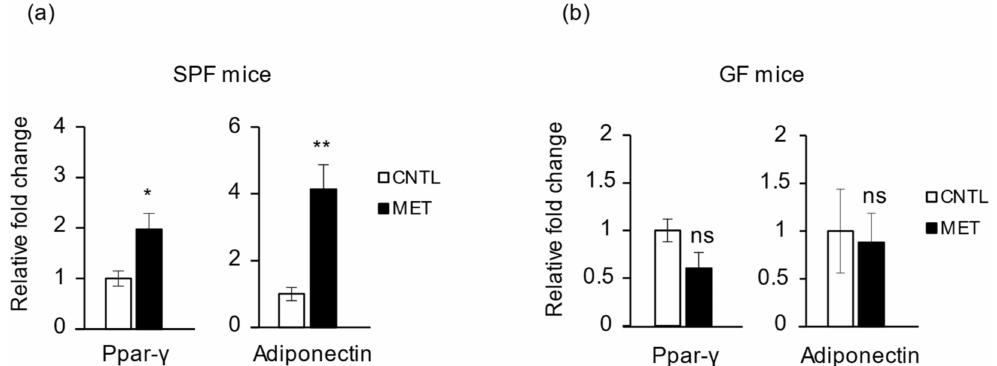
Figure 6. Metronidazole modulates skeletal muscle adiponectin and PPAR γ expression. Real-time quantitative PCR analysis of PPAR γ and adiponectin expression in gastrocnemius muscle of metronidazole-treated and nontreated ( a ) SPF ( a ) and ( b ) GF mice. N = 5 mice per group. Data presented as means ± SEM. Asterisks indicate statistically significant differences (*, p < 0.05; **, p < 0.01; ns, nonsignificant with student’s t